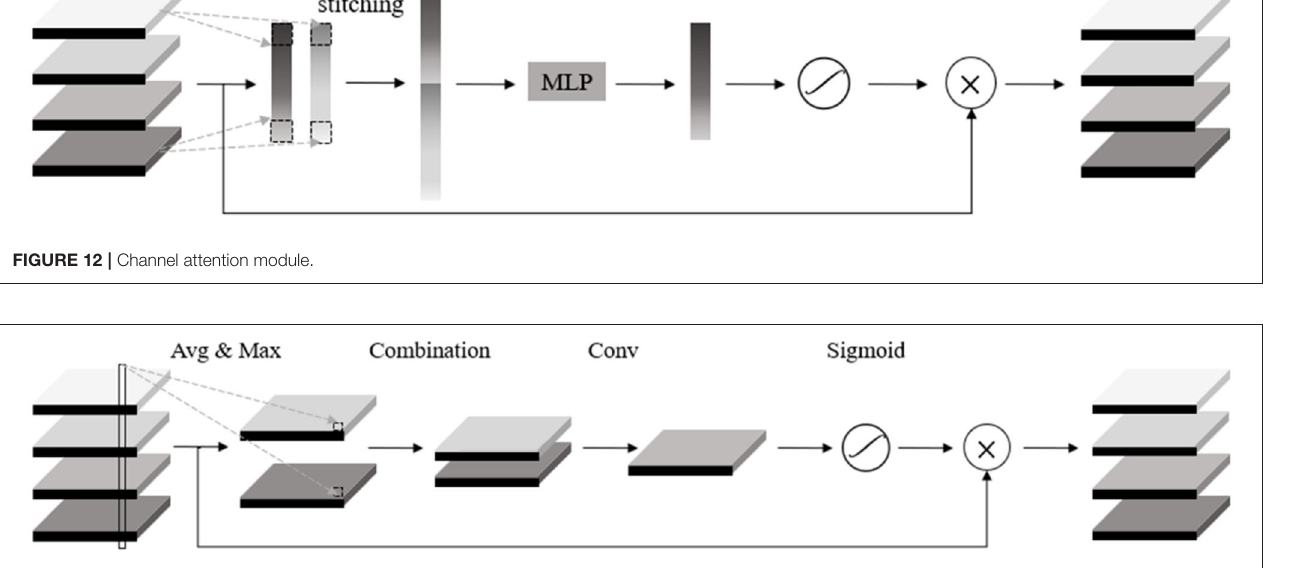
FIGURE 13 | Spatial attention